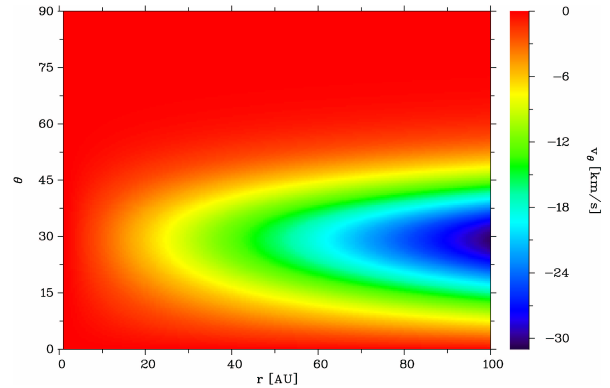
Fig. 3. The perturbation of the radial velocity component. The labels are analogous to that of Fig. 2.